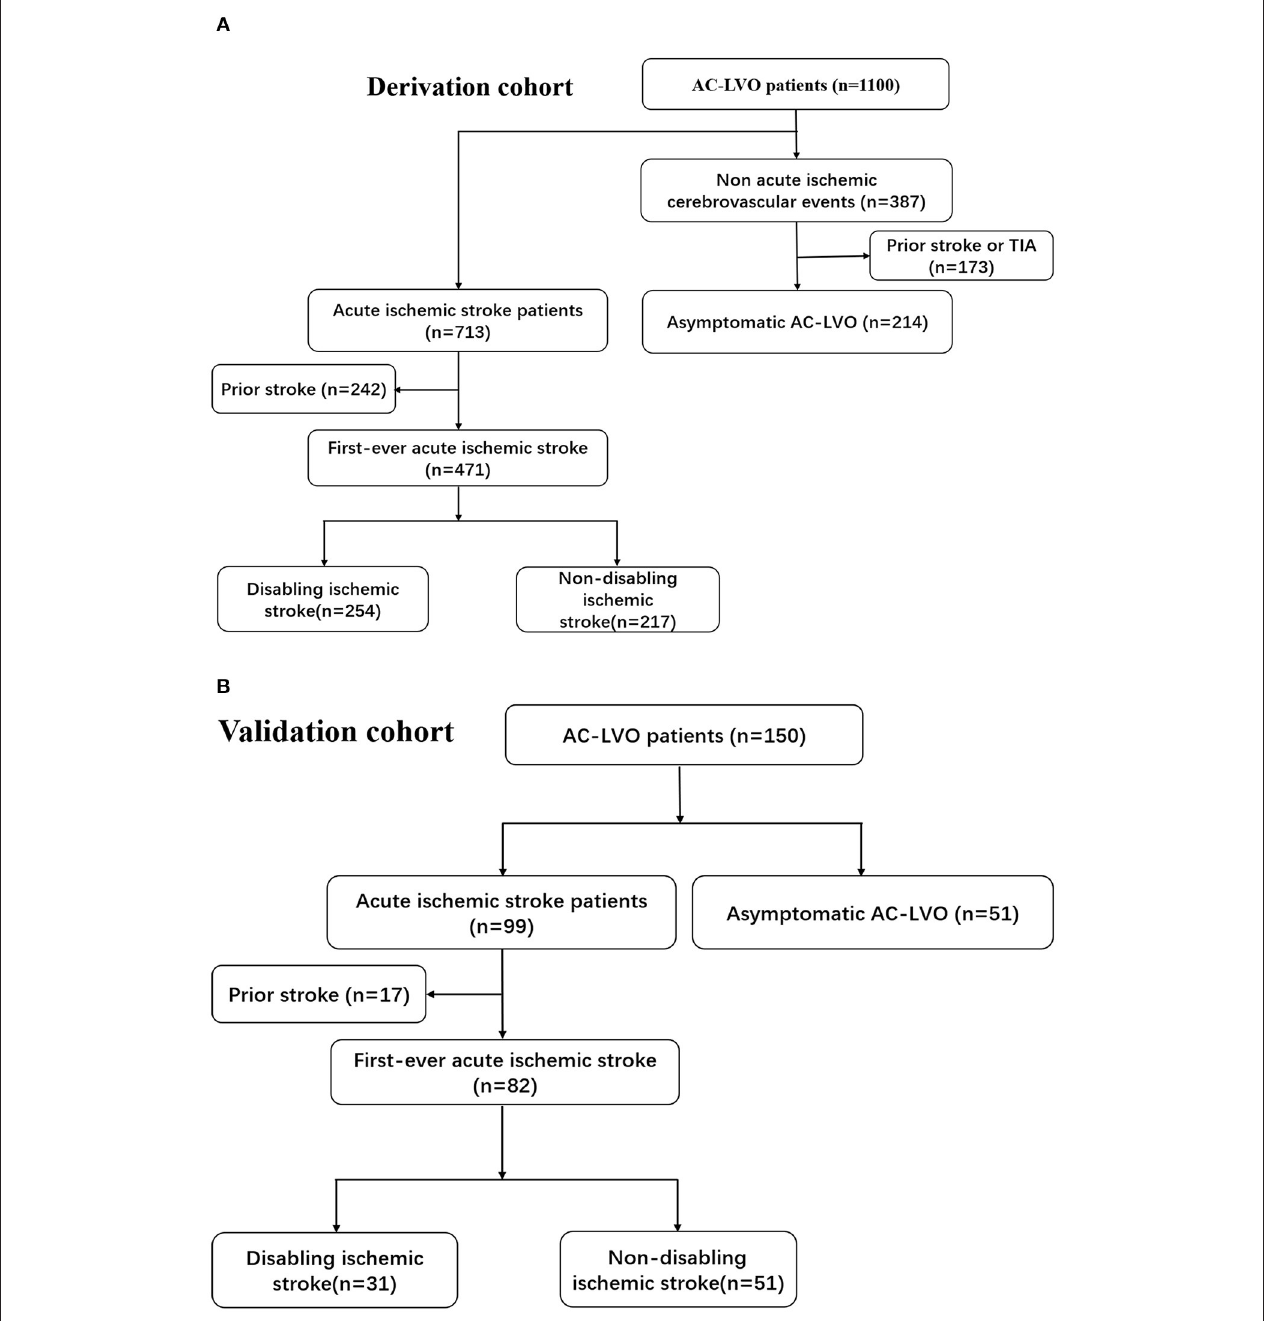
FIGURE 2 | The flow diagram of the patients included in this study is shown in (A,B) . higher than that in RF, when using the Delong test with Bonferroni correction (LR vs. RF, P = 0.0048; RLR vs. RF, P = 0.0048, SVM vs. RF, P = 0.0006; Figure 3B ). In Model 2, there was no difference in AUCs among the four machine learning algorithms ( Figure 3D ). The AUC of each algorithm was as follows: LR 0.68 (95% CI 0.56–0.8), RLR 0.76 (95% CI